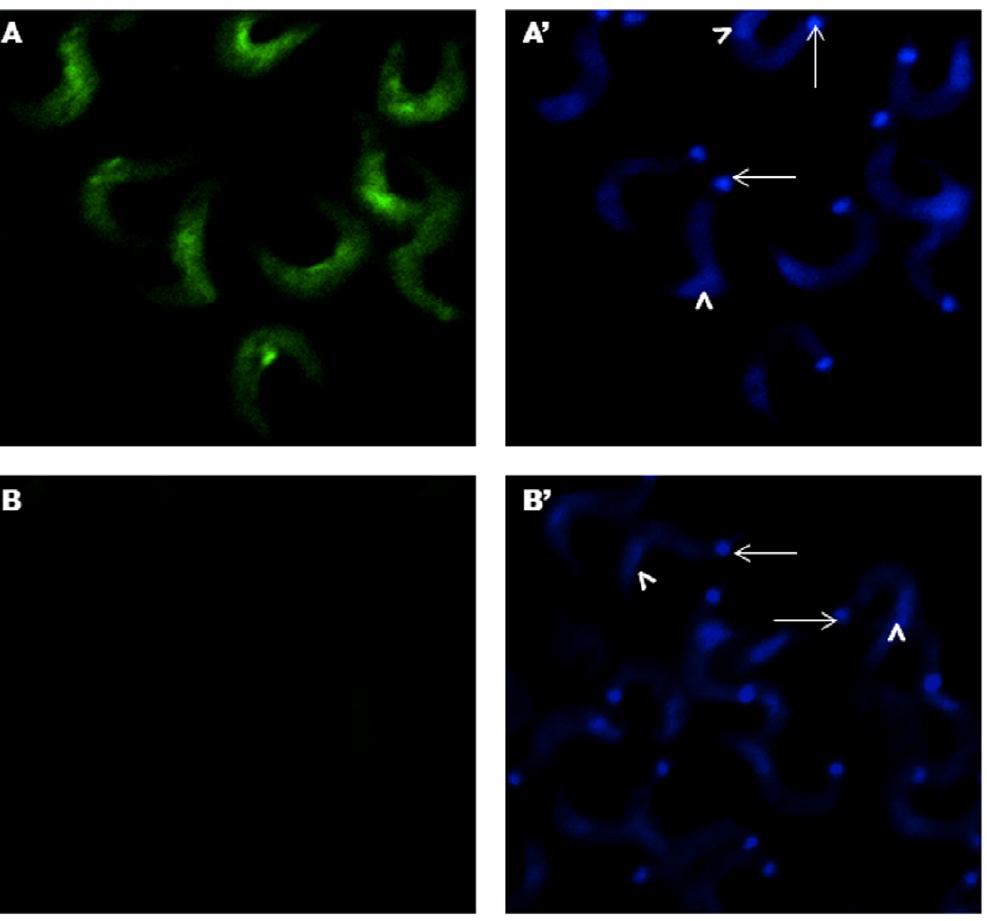
Figure 1. TSP-1 binds to the surface of infectious T. cruzi trypomastigotes. A , Alexa-488 labeled TSP-1 binds to the surface of paraformaldehyde fixed T. cruzi trypomastigotes as seen by fluorescence microscopy. A’ , DAPI stained preparation of A showing parasite nuclear DNA (arrow heads) and k-DNA (arrows). B , Binding of Alexa-488 labeled TSP-1 to paraformaldehyde fixed T. cruzi trypomastigotes is inhibited by 100X unlabeled TSP-1. B’ , DAPI stained preparation of B showing parasite nuclear DNA (arrow heads) and k-DNA (arrows). This figure shows the results of a representative experiment selected from three independent experiments with similar results.